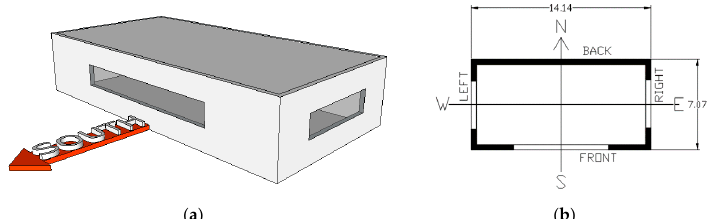
of view. Figure 1 graphically represents a 100 m 2 building with an aspect ratio equal to 2, windows-to-floor surface ratio of 15% and orientation angle of 0 ◦ (south orientation of the front wall).